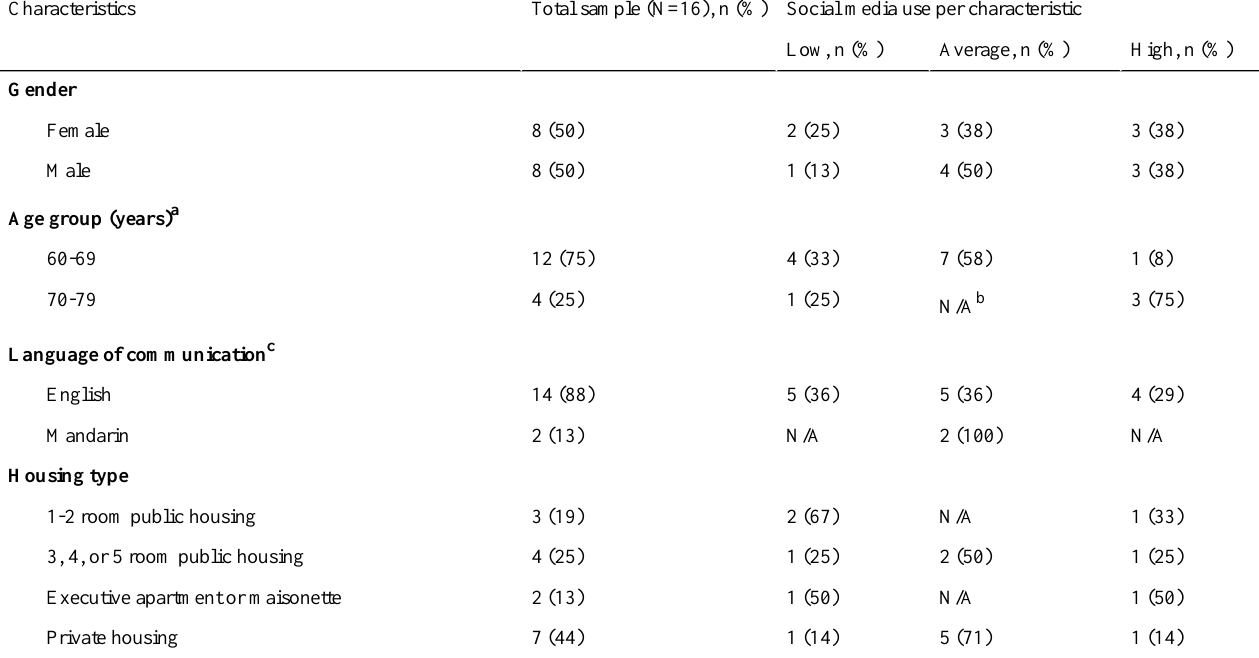
Table 1. Sociodemographic data of participants (N=16) and the distribution of social media use by sociodemographic groups.